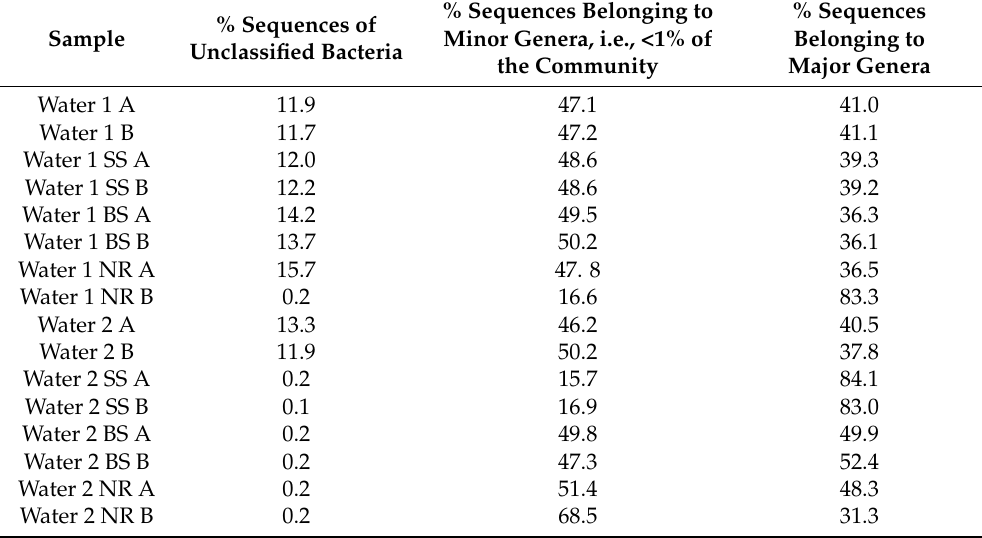
Table 4. Relative amounts of sequence reads of unclassified bacteria, reads belonging to genera contributing with less than 1% of the sequences in any sample or belonging to major genera. SS— sandstone, BS—black shale, NR—no rock.